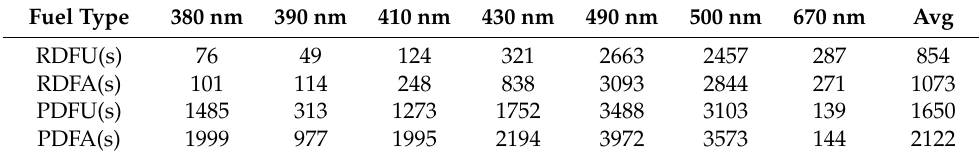
Table 5. Signals shifts S(max)–S(200s) of initial degradation in DHE:UVonTon cycle.